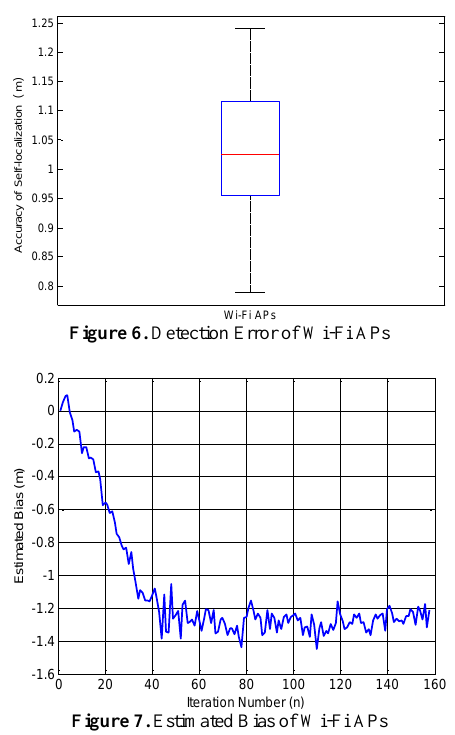
Figure 7. Estimated Bias of Wi-Fi APs